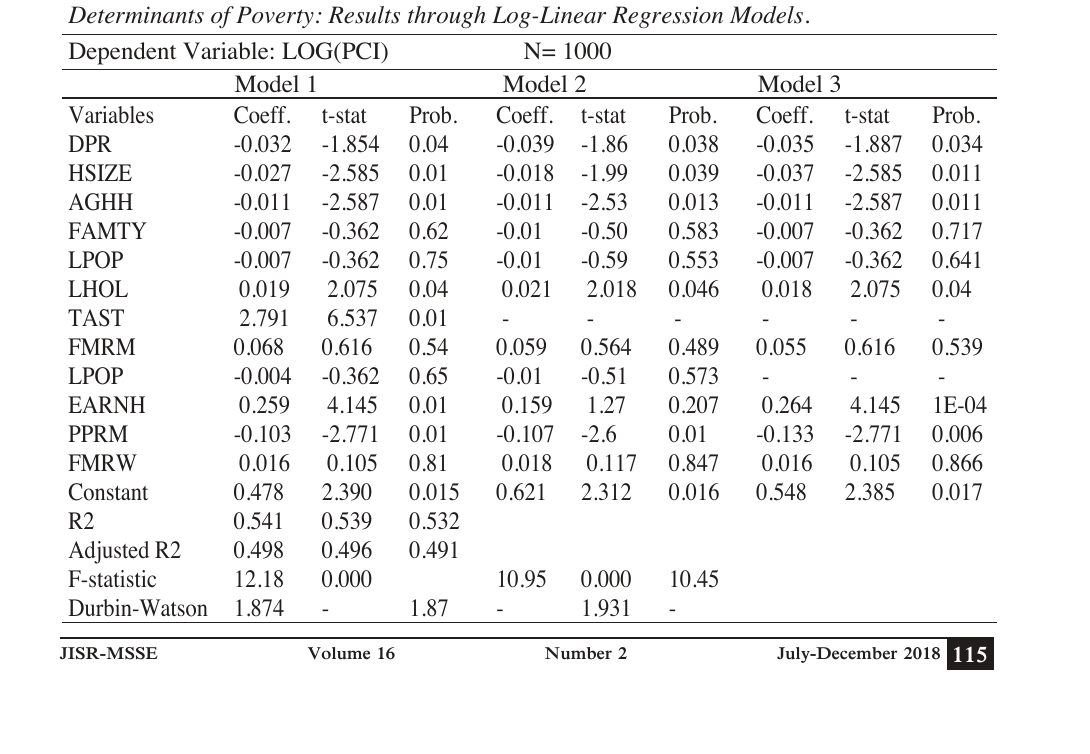
Determinants of Poverty: Results through Log-Linear Regression